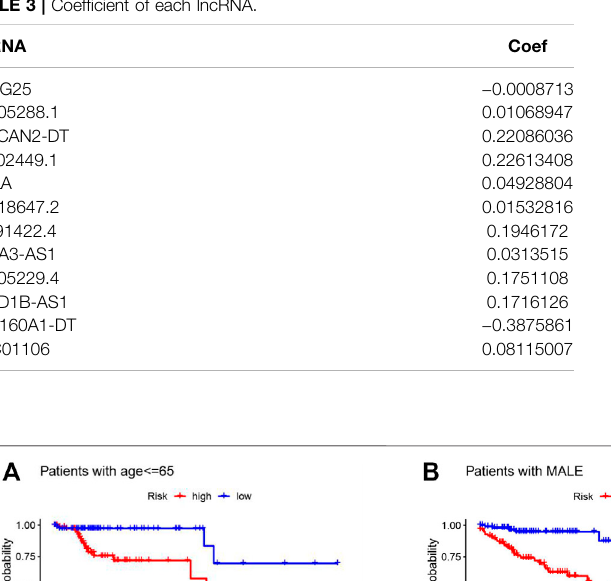
Frontiers in Cell and Developmental Biology |